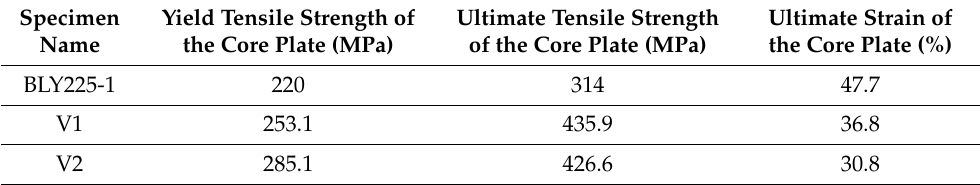
Table 1. Test information of BRBs.